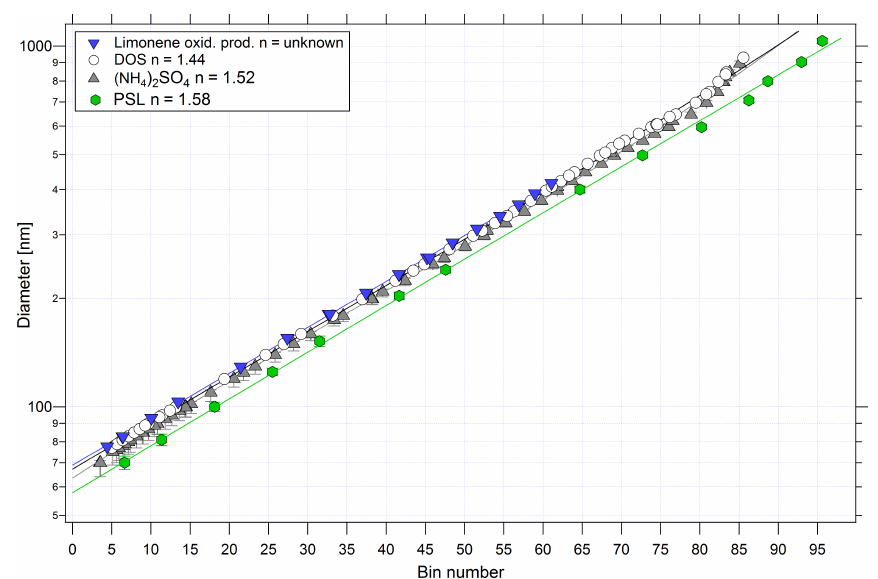
Figure 3. Calibration particle diameter as a function of UHSAS-2 (not thermodenuded) bin number for particles composed of PSL, (NH 4 ) 2 SO 4 , DOS, and limonene ozonolysis products. Solid lines represent fits to the data. Uncertainties are shown for (NH 4 ) 2 SO 4 and PSL but are often obscured by the symbols.